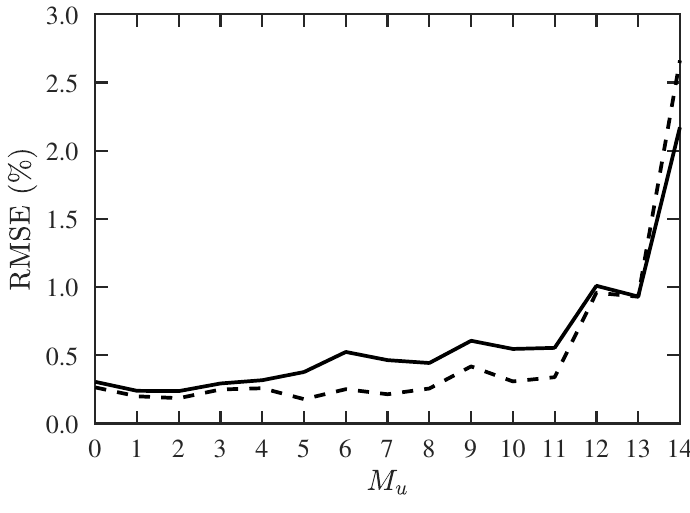
Figure 6. RMSE of DOA and CF estimation with proposed PJE algorithm, under different numbers of signals with unknown CF, SNR = 10 dB, Q = 300, M = 30. ———: RMSE of DOA, − − − : RMSE of